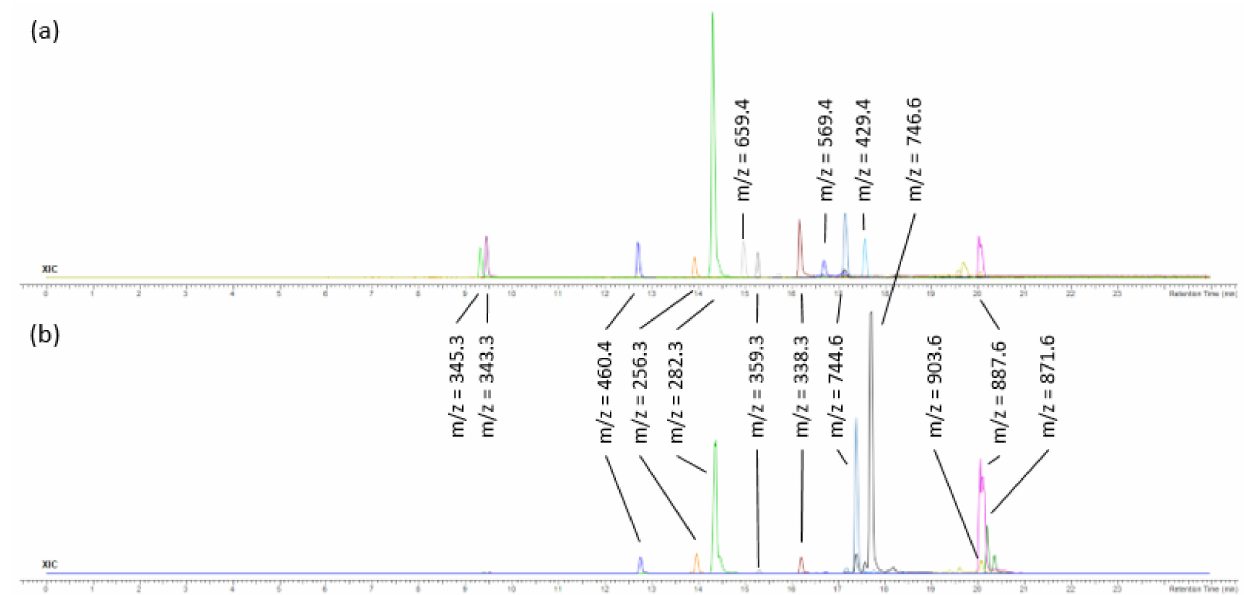
Figure 1. Total ion chromatograms (TIC) of the fractions ( a ) F3 and ( b ) F4.